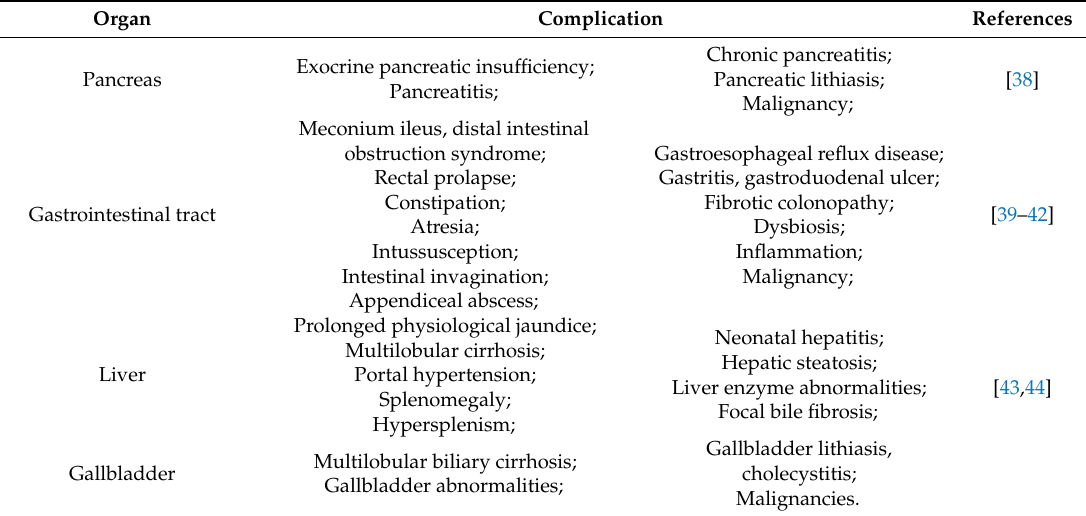
Table 2. Gastrointestinal manifestations in CF